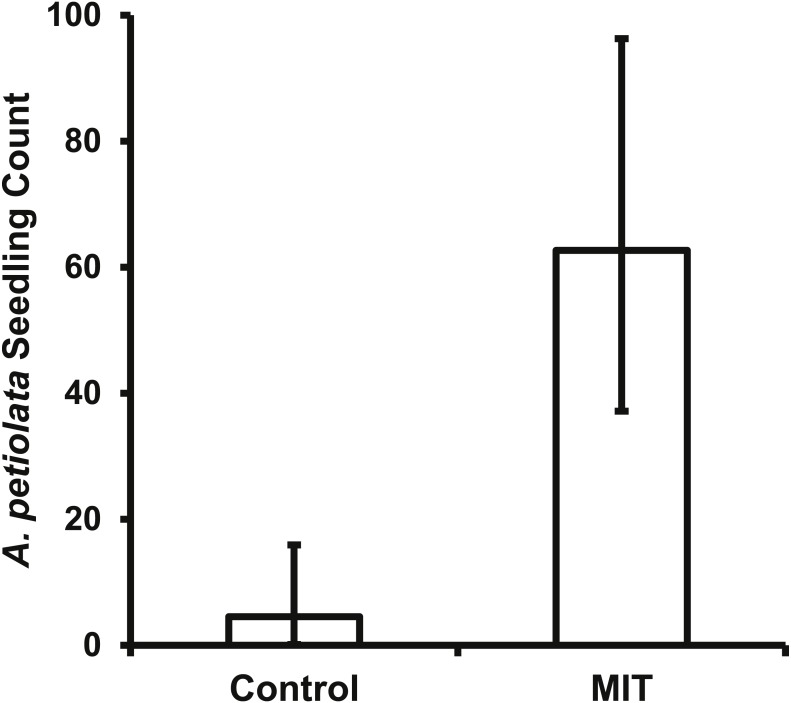
The back transformed mean number (±95% CI) of A. petiolata seedlings counted in the germination trays of the two treatments.The confidence intervals are not symmetrical because of the back transformation. The MIT trays (p < 0.0001) had significantly more seedlings than the control trays.